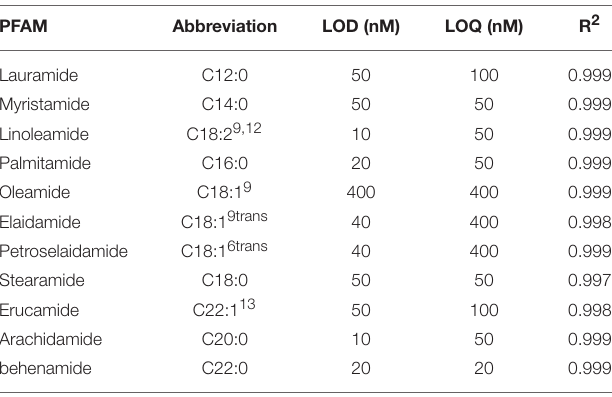
TABLE 2 | LOD and LOQ for select PFAMs determined by injection of 2 µ L standard solutions from 500 pM to 10 µ M.